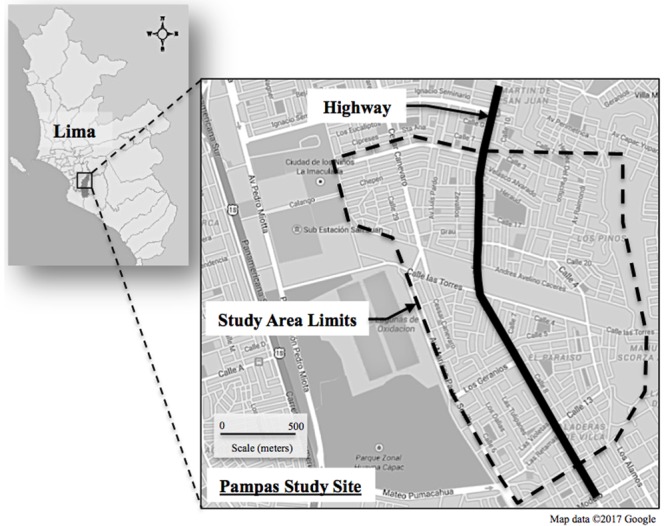
Map of Pampas de San Juan de Miraflores location in Lima, and study area limits in relation to the highway.